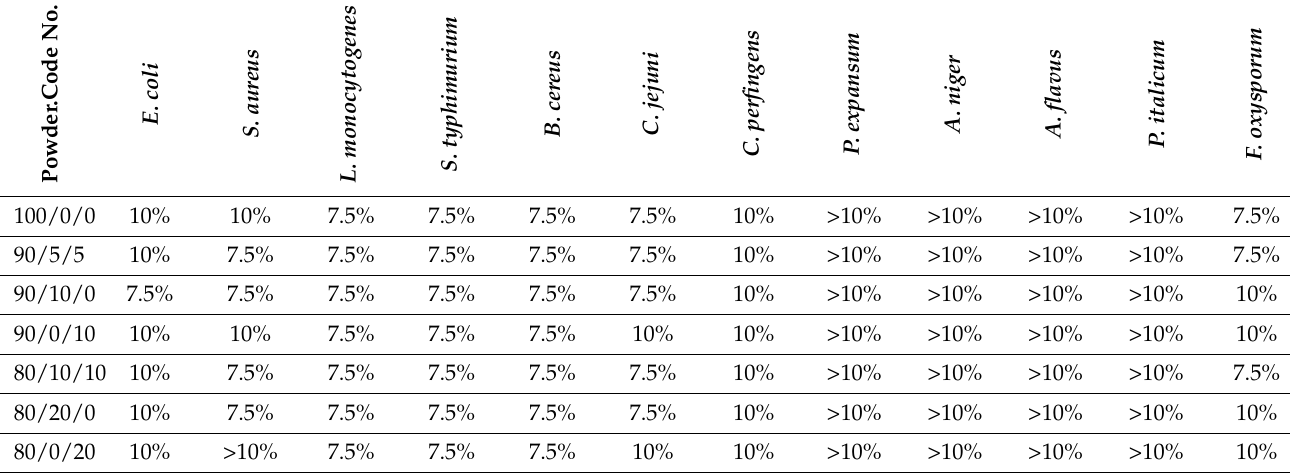
Table 2. Minimum inhibitory concentration of selected antimicrobial powders against several foodborne bacteria and fungi. o . N e d o C c . E . e r d w o P